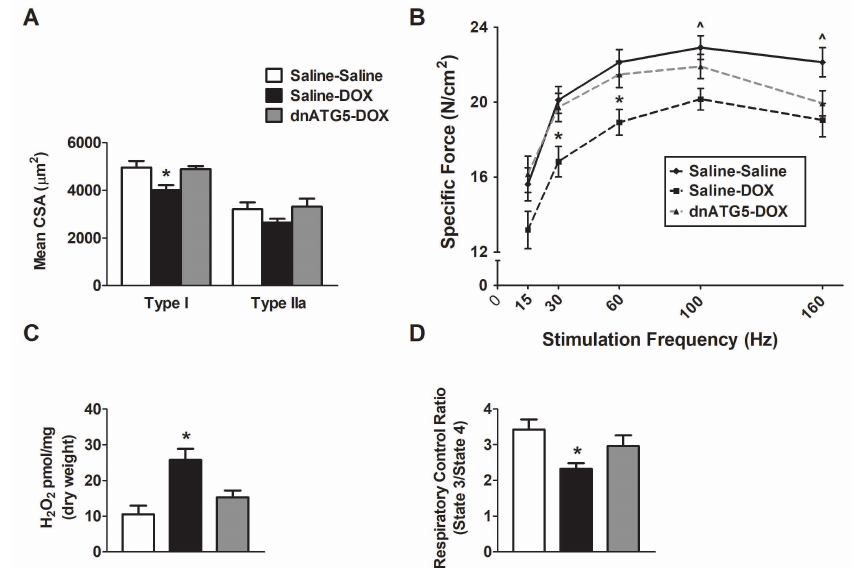
Figure 3. E ff ects of DOX and rAAV-dnATG5 administration on ( A ) soleus muscle fiber cross-sectional area (CSA), ( B ) soleus muscle-specific force production, ( C ) mitochondrial hydrogen peroxide (H 2 O 2 ) emission, and ( D )mitochondrialrespiratorycontrolratio(RCR). Valuesarerepresented asmeans ± SEM. * significantly di ff erent versus all groups ( p < 0.05). ˆ significantly di ff erent versus Saline-DOX ( p < 0.05).